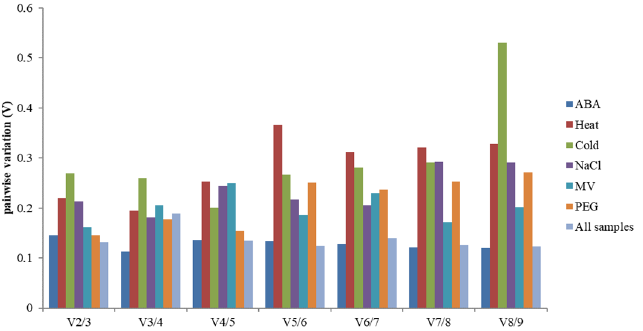
Figure 4. The V value analysis of 9 candidate genes under abiotic stress by geNorm. Pairwise variation (Vn/Vn + 1) analysis of 9 candidate reference genes analyzed in six sample subsets.